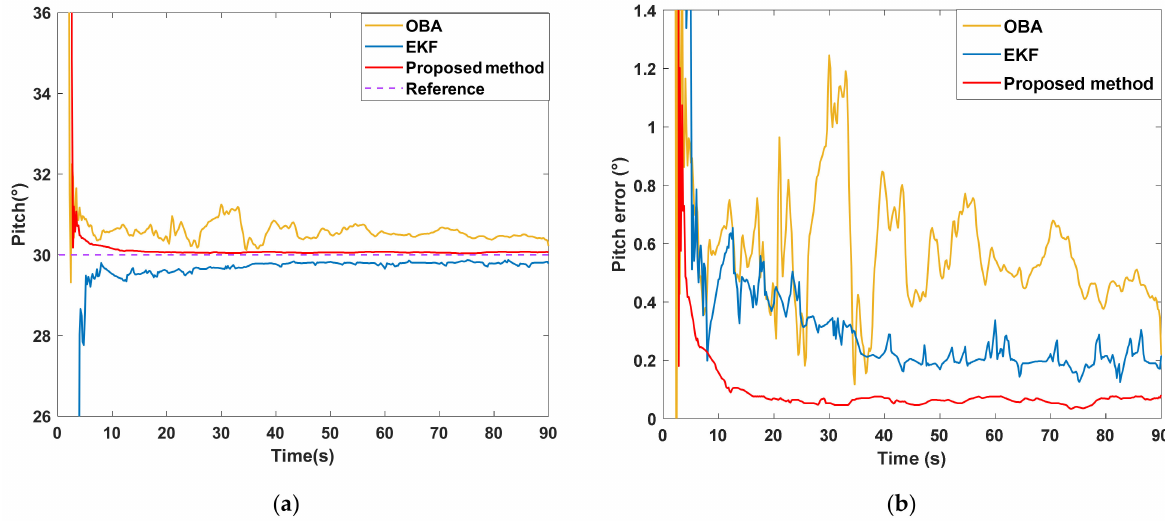
Figure 8. Simulation results of pitch angle alignment with different alignment methods. ( a ) Pitch angle alignment results of different alignment methods; ( b ) absolute value of pitch alignment error of different alignment methods.